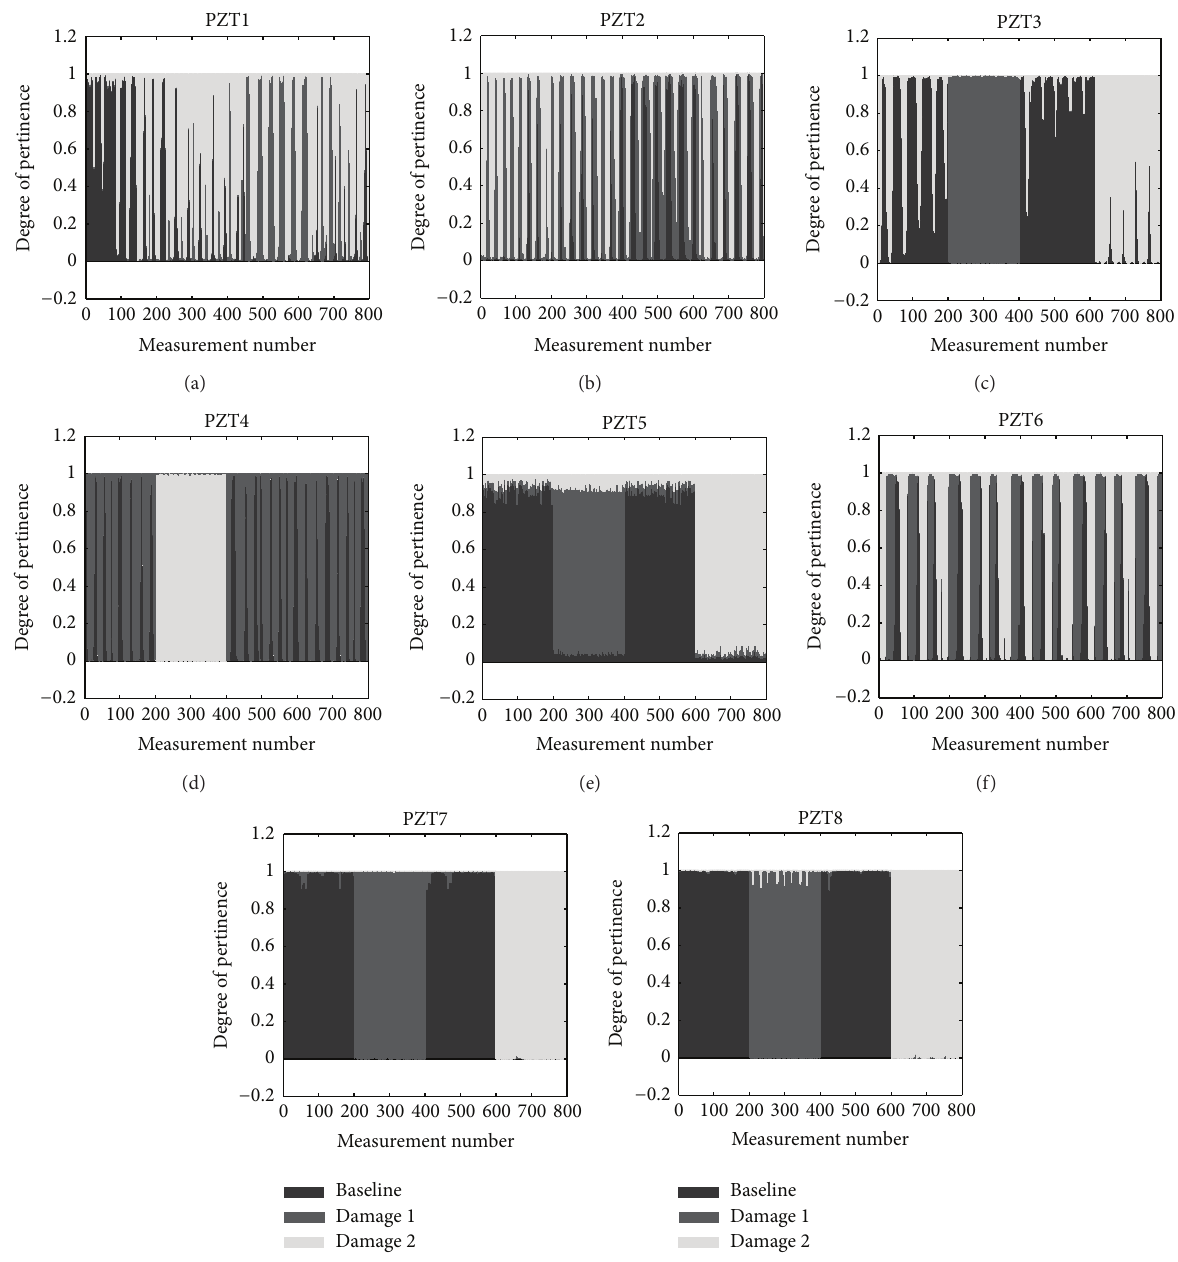
Figure 4: Final degree of pertinence for the aircraft